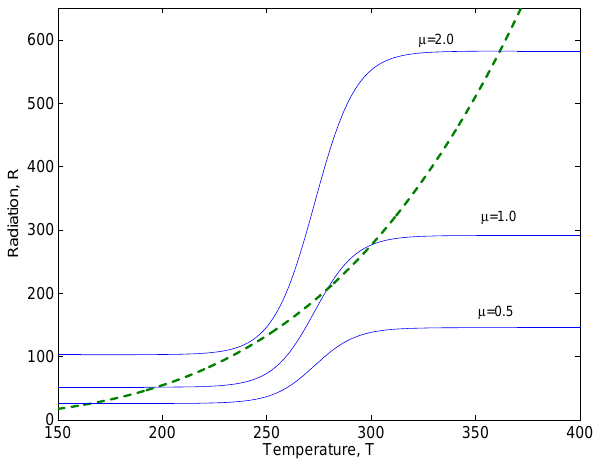
Fig. 6. Equilibrium solutions of the EBM (15) for ice-albedo feed- back functions 𝛼 = 𝛼 ( 𝑇 ; 𝜅 ) given by Eq. (13) and corresponding to the steepness parameter values 𝜅 = 0 . 01 , 0 . 05 , 0 . 1 and 1. Notice the deformation of the stable (blue, solid lines) and unstable (red, dashed lines) solution branches: the “cold” tipping point moves to the left, away from 𝜇 = 1 . 0 , as 𝜅 increases; compare Fig. 3a.